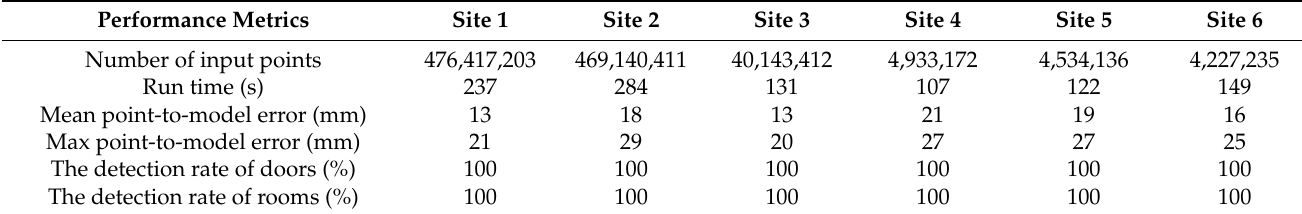
Table 1. The key performance metrics of the proposed approach.